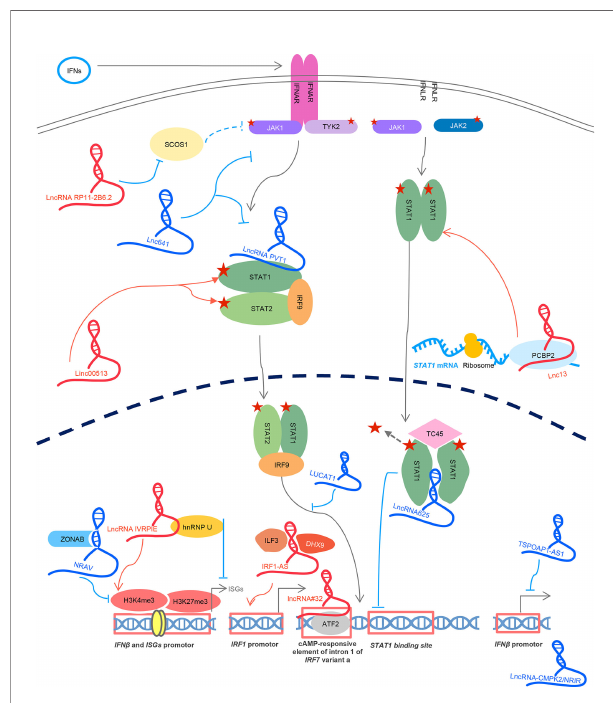
FIGURE 6 | LncRNAs regulates IFN and ISG transcription. IFN signals through binding to the receptors and activation of downstream JAK-STAT cascades. LncRNA RP11-2B6.2, linc00513, and lnc13 enhance JAK-STAT activities. LncRNA IVRPIE, IRF1-AS, and lncRNA#32 enhance IFN and ISG transcription. Lnc641, PVT1, lncRNA625, and LUCAT1 downregulate JAK- STAT activity. LncRNA TSPOAP1-AS1, NRAV, and lncRNA-CMPK2 decrease IFN and ISG transcription. Five-sided star represents phosphorylation modi fi cation. LncRNA in blue represents negative regulators; lncRNA in red is positive regulators for IFN